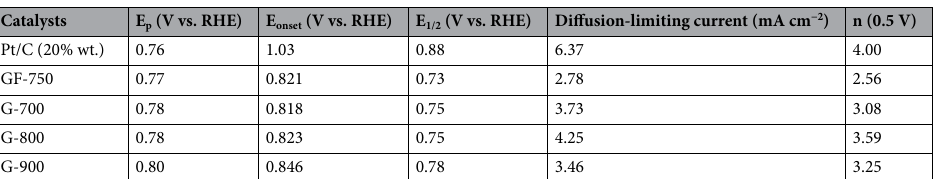
Table 4. ORR performance parameters of the obtained reactor carbon and commercial Pt/C catalysts tested in alkaline media.